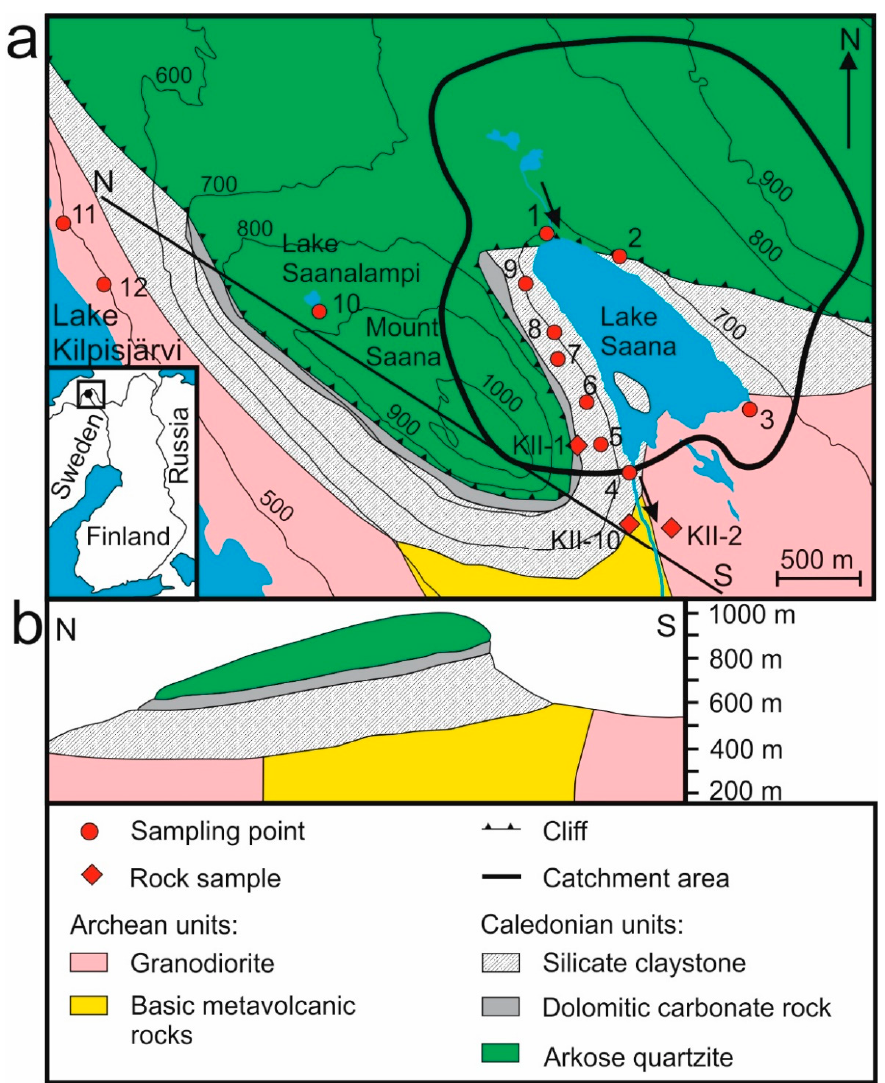
Figure 1. A schematic map of Lake Saana and Saanalampi catchments showing the positions of sampling points ( a ) and the cross-sections from northwest to southeast ( b ).